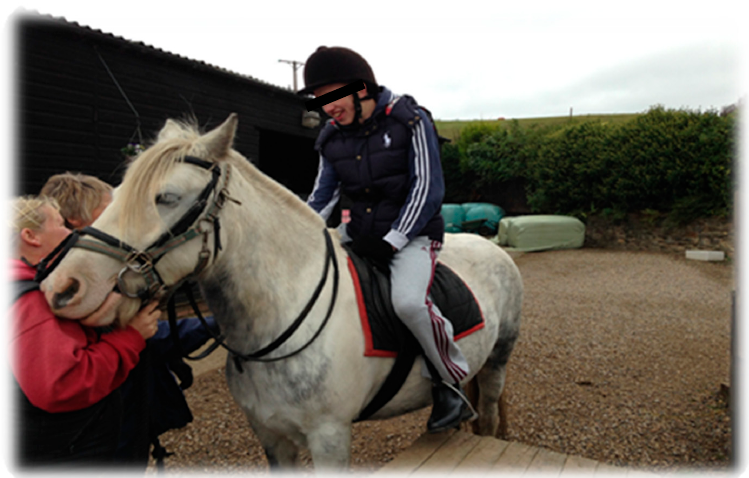
Figure 6. Embodied transformation. “…like a legend being on top of them. You feel so big. You